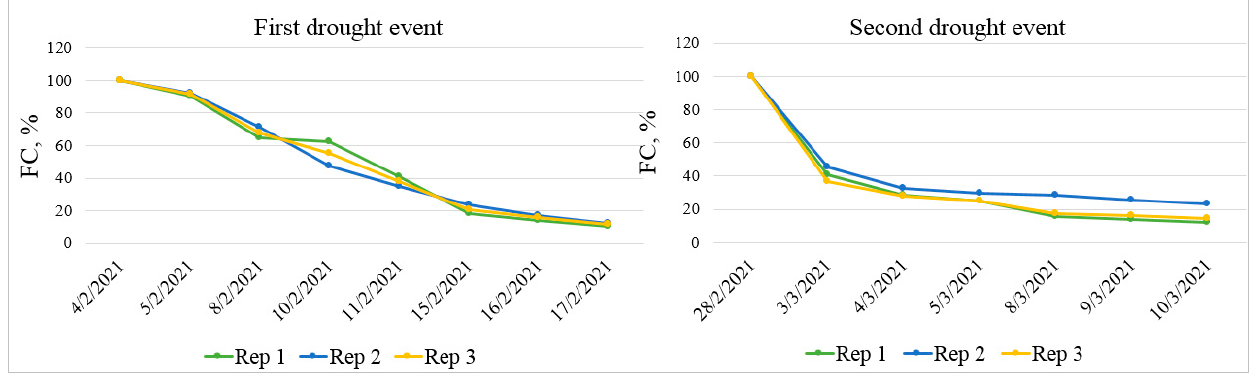
Figure 2. Pots’ water content in terms of percentage of field capacity (FC, %) for first and second drought treatments.